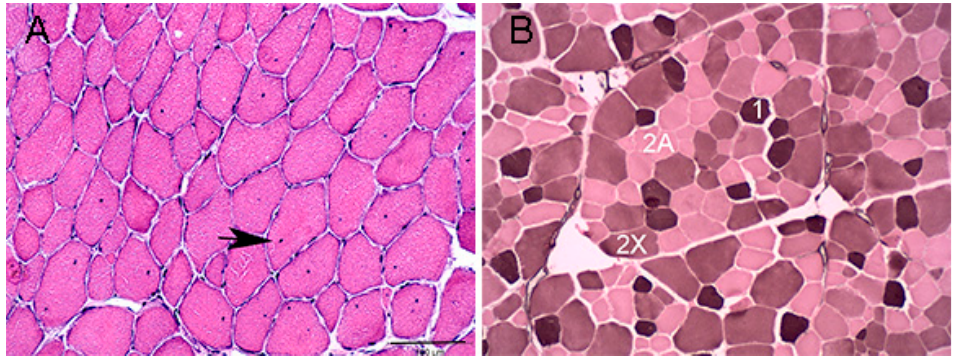
Figure 1. Cross section of gluteal muscle from an RER-susceptible STD. ( A ) Hematoxylin and Eosin stain showing numerous mature myofibers with internalized myonuclei 20×. ( B ) ATPase stain with pH 4.4 acid preincubation showing three muscle fiber types. Table 1. The number of control and RER-susceptible mares, mean (SD) age, sex, time lapse between exercise and muscle biopsy, plasma creatin kinase (CK), and aspartate transaminase (AST) activities and fiber type composition for gluteal muscle type 1, 2A and 2X fibers. Information on individual horses is found in Table S1. RER-susceptible horses had significantly more type 1 fibers than con- trols. 1 ref. range 127–412, 2 ref. range 194–346.